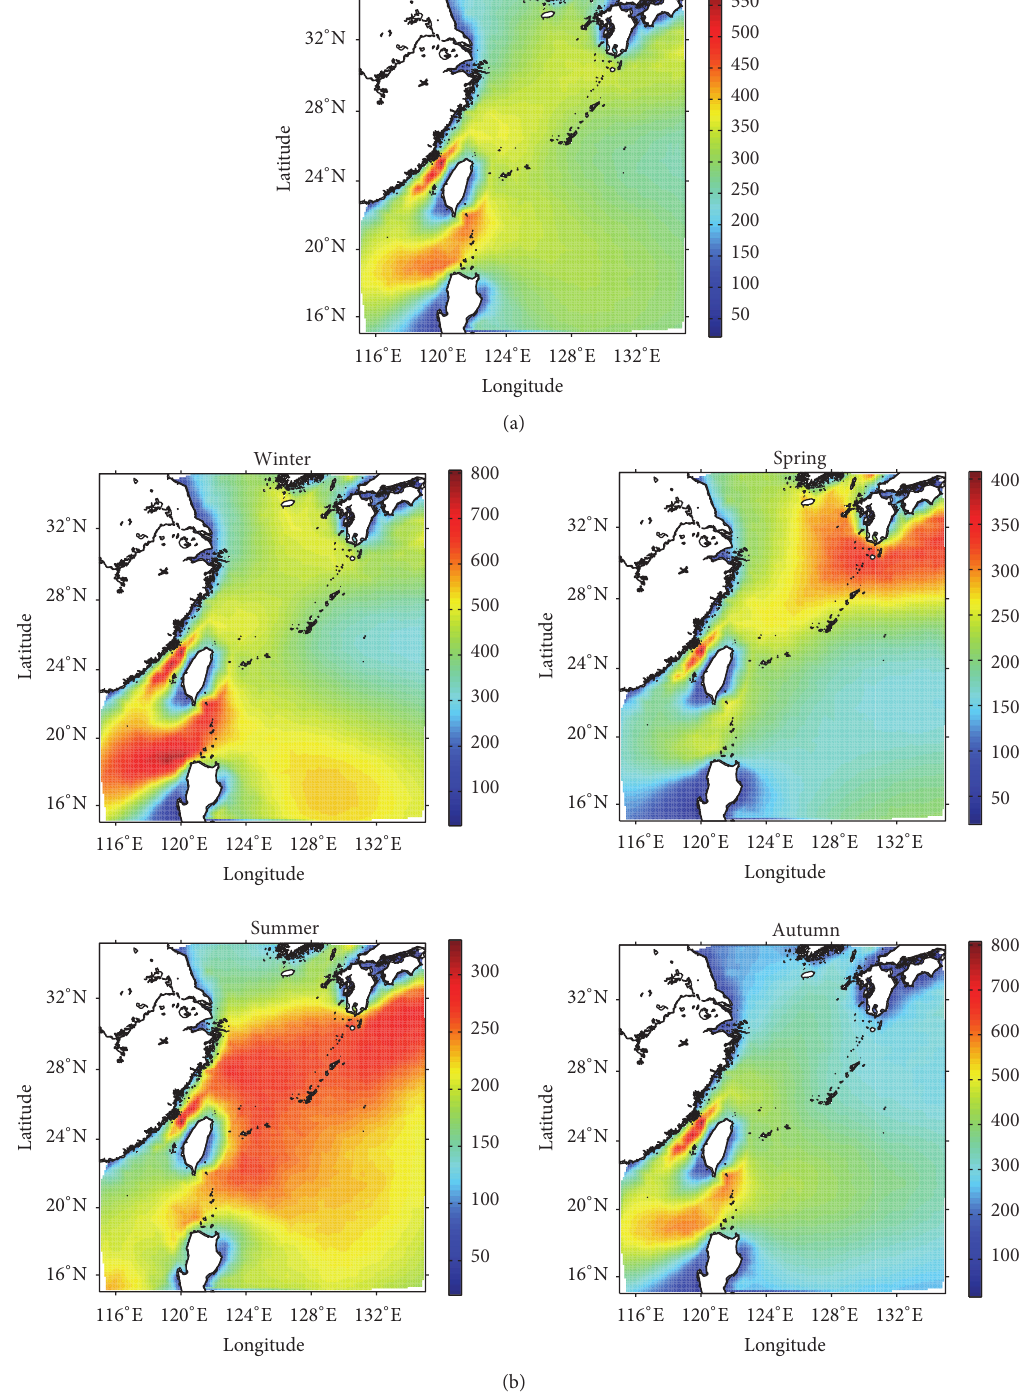
Figure 11: (a) Annual and (b) seasonal distribution of wind power density for the period 1980–2009 in the ECS. Values on the side bars are in w/m 2